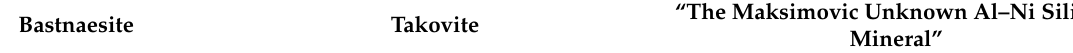
Table 5. X-ray powder diffraction data for Bastnaesite and Al–Ni–silicates from the Nissi (Patitira) bauxite laterite deposit. Data from [12] concerning “the unknown Al–Ni–silicate mineral” from the nearby Aghios Ioannis deposit, are given for